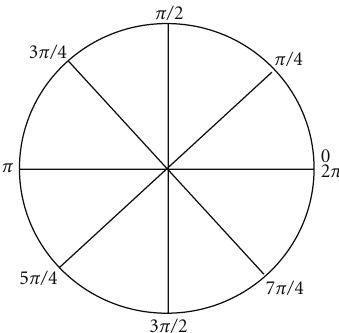
Figure 6: Mapping of coordinate space into octants.